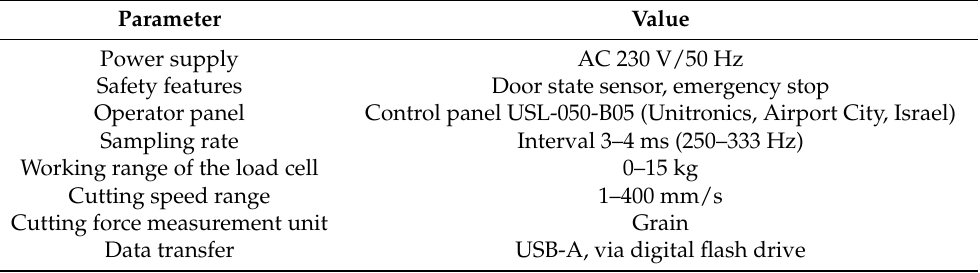
Table 1. Technical parameters of the cutting force measurement station [9].